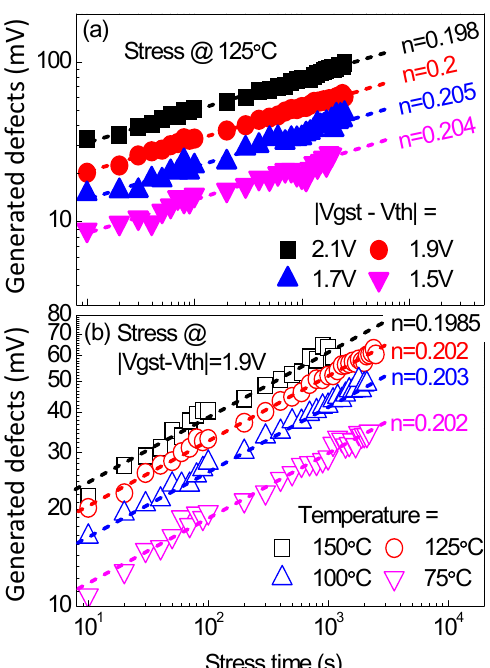
Figure 28. The kinetics of Generated Defects under different stress voltages ( a ) and different temperature ( b ). The power exponents are insensitive to either the stress bias or temperature [38].